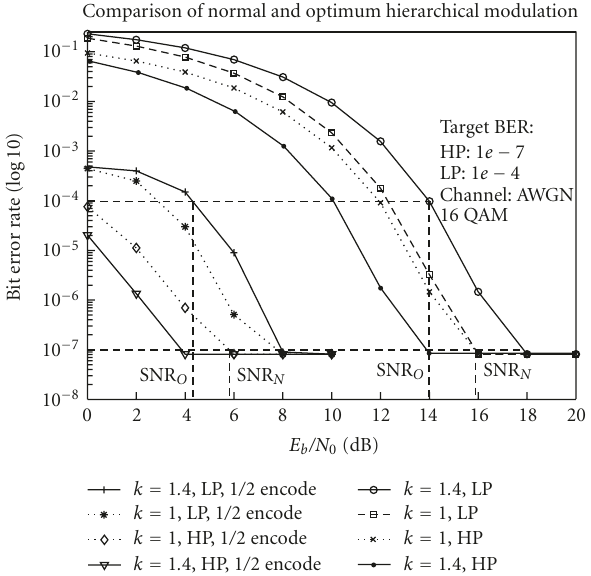
Figure 7: Comparison of required SNR per bit for k = 1 and k = 1 .